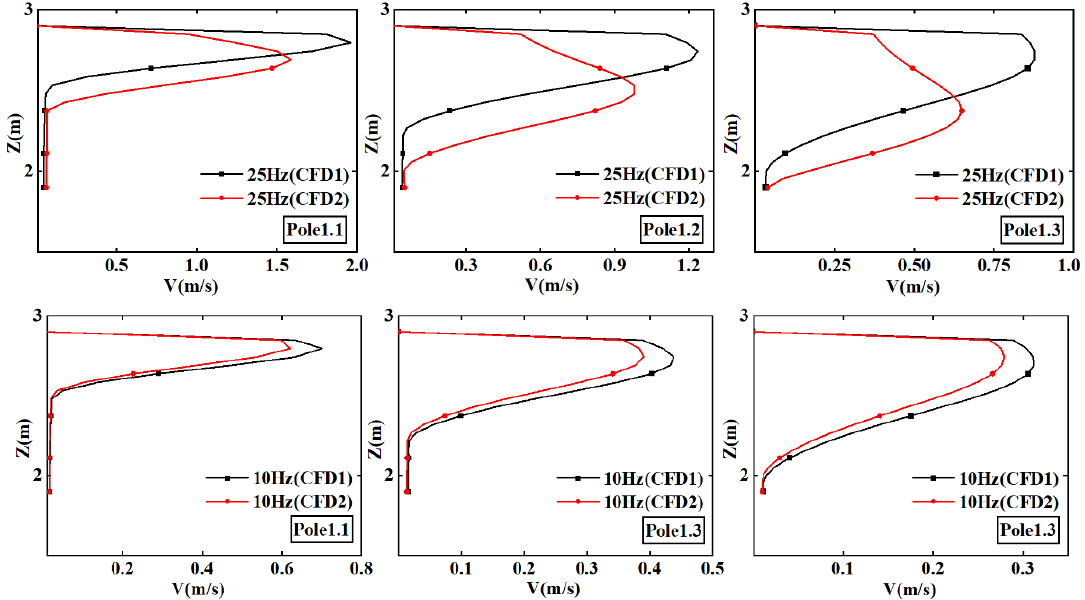
Figure 14. Calculated velocity profiles for SCD at three positions.